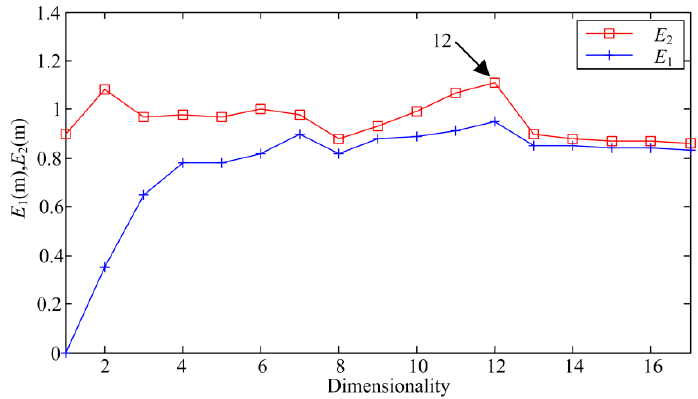
Figure 8. Selection of the embedding dimension by CAO method.